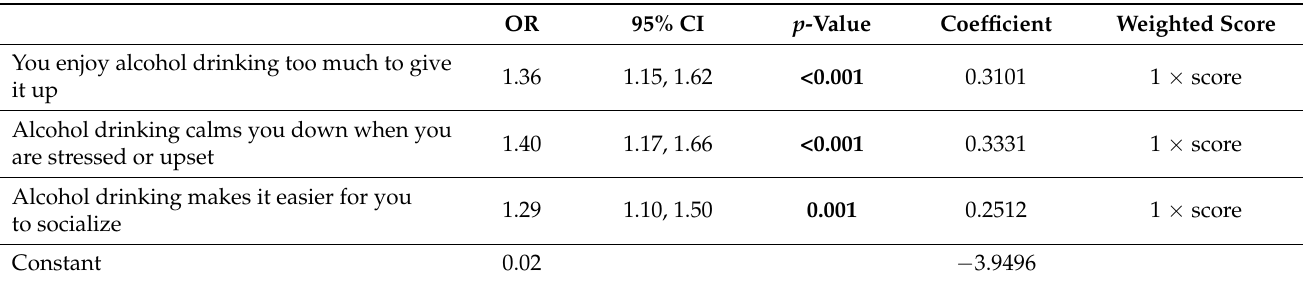
Table 3. Final multivariable model after stepwise backward elimination of non-significant predictors of high-risk drinking behavior. (n = 1401).